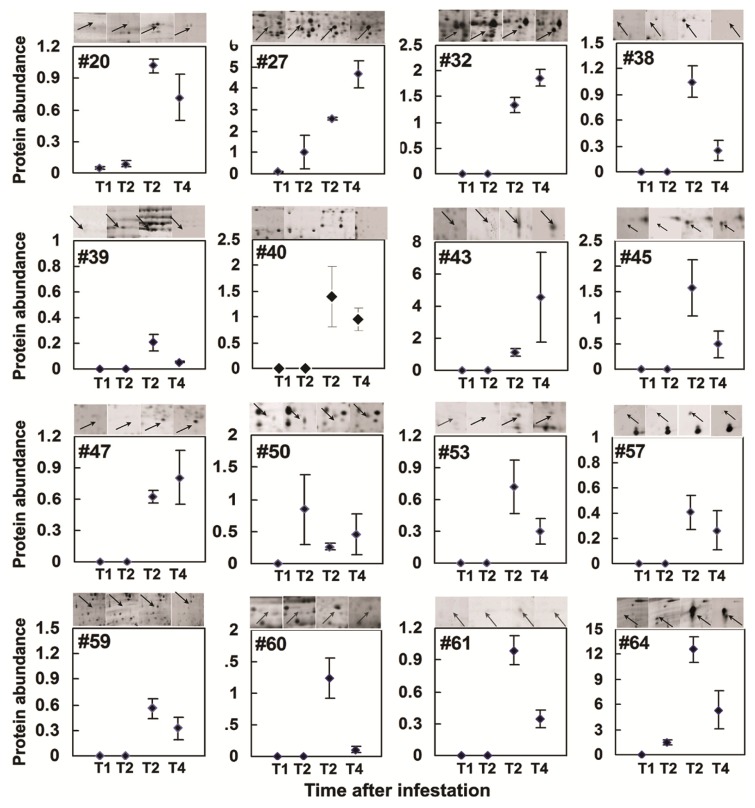
Relative abundance of brown planthopper (N. lugens) responsive proteins in IR64 at different days after BPH infestation (DAI) (T1 = 2 DAI; T2 = 13 DAI; T3 = 28 DAI; T4 = 34 DAI)). Mean ± SE (n = 3).